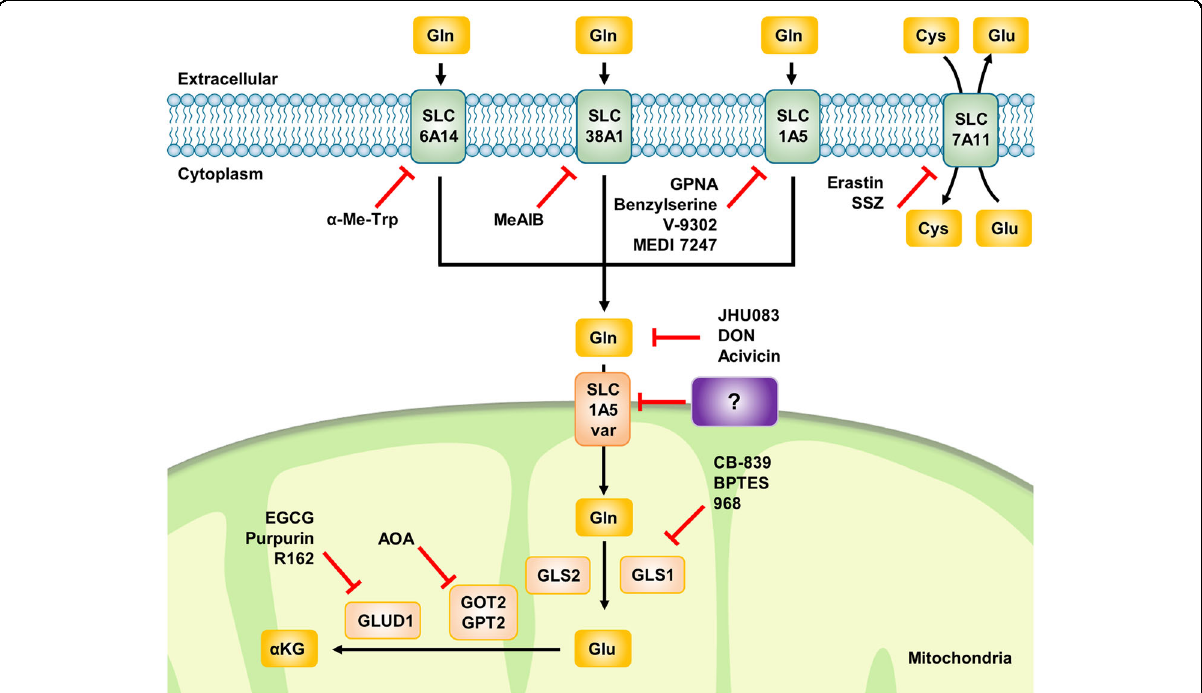
Fig. 8 Inhibitors of glutamine transporters and glutaminolysis. For the principal inhibition of glutaminolysis, attempts have been made to target the amino acid transporters related to these pathways. SLC6A14 and SLC38A1 are inhibited by α -Me-Trp and MeIAB, respectively. The most intensely researched topic is inhibitors of SLC1A5, a major glutamine transporter, which include substrate analog competitive inhibitors such as GPNA, benzylserine, and V-9302 and the inhibitory antibody MEDI7247. Although they exhibit low potency, inhibitors of SLC7A11 include erastin and SSZ. Inhibitors of glutaminolytic enzymes are agents that target GLS1, GOT2, and GLUD1. CB-839, an agent in its 2nd clinical trial, inhibits GLS1 similarly to BPTES and 968. AOA inhibits GOT2 activity, and EGCG, purpurin, and R162 inactivate GLUD1. However, the SLC1A5 variant, the sole glutamine transporter discovered to date, is expected to be a much more effective target for cancer therapeutics than previously studied glutaminolysis inhibitors. Cys cysteine, Glu glutamate, α -KG α -ketoglutarate, GLS glutaminase, GOT2 glutamic-oxaloacetic transaminase 2, GPT2 glutamic-pyruvate transaminase 2, GLUD1 glutamate dehydrogenase 1, α -Me-Trp alpha-methyl-tryptophan, MeAIB methylaminoisobutyric acid, GPNA L- γ